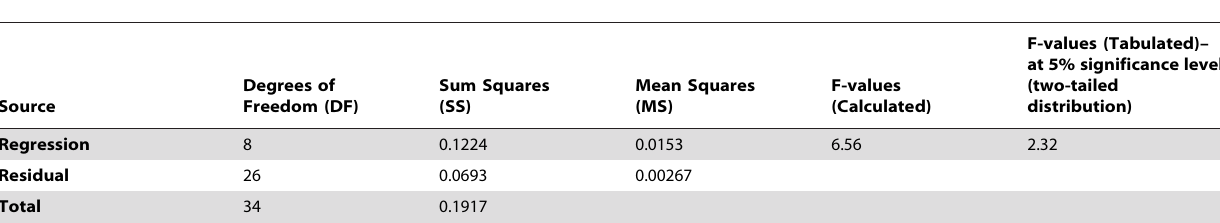
Table 1. ANOVA table of Regression.